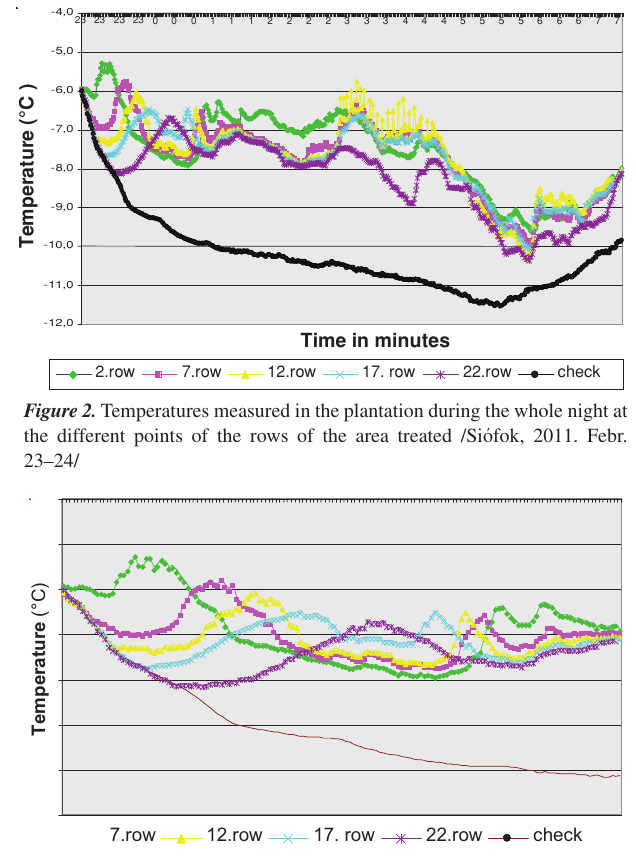
Figure 3. Changes in temperature after the first round completed by Frostbuster at the beginning of the cycle of measurement /Siófok, 2011. Febr. 23–24/